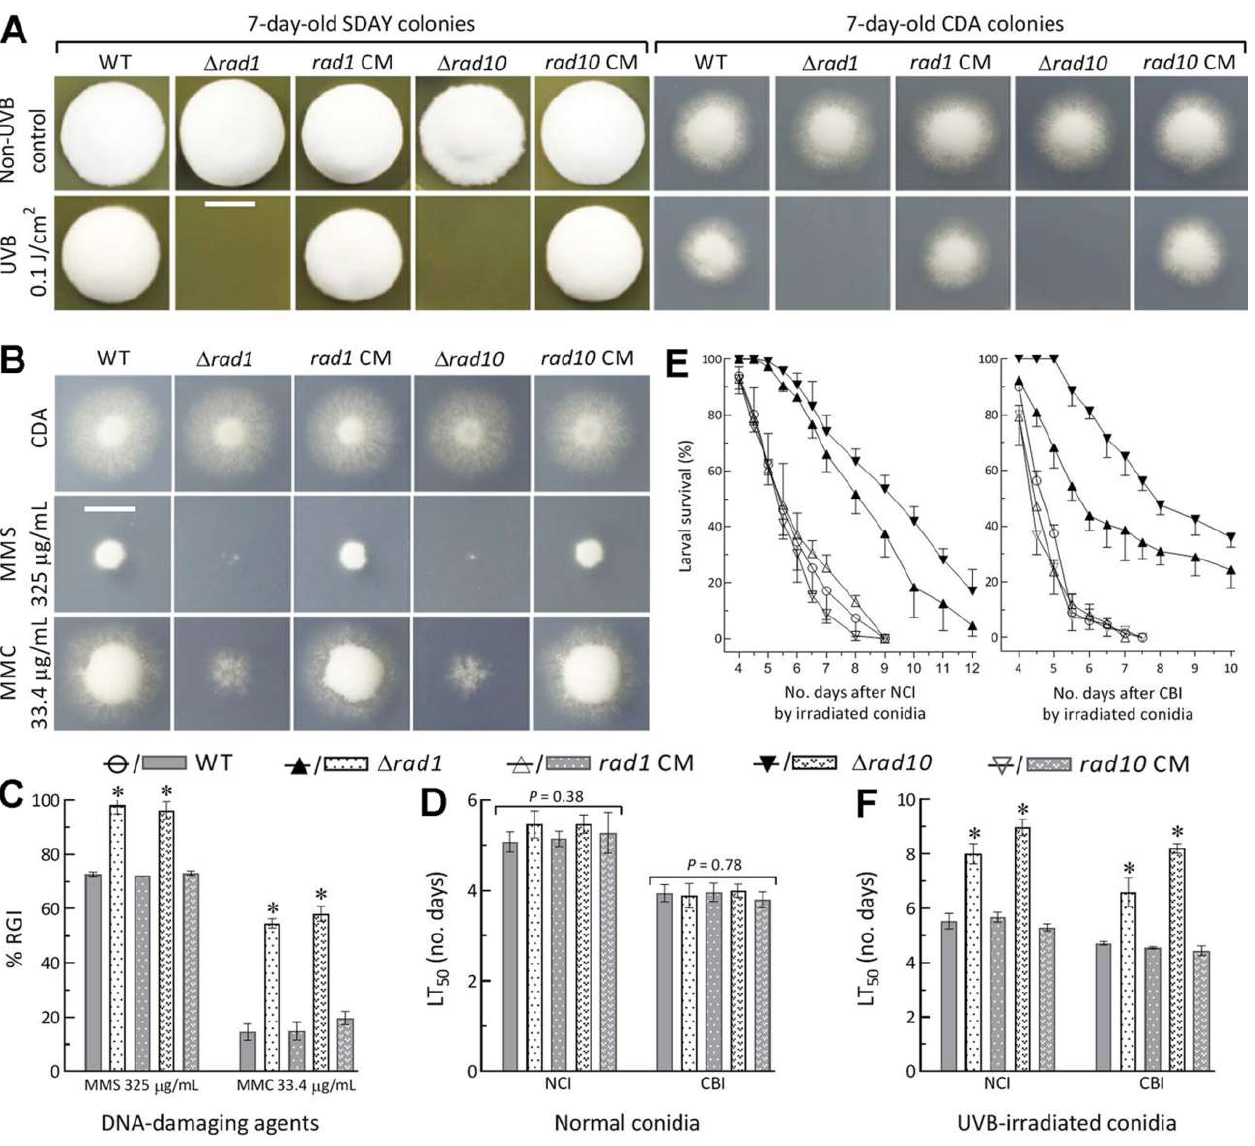
Figure 2. Essential roles of Rad1 and Rad10 in preventing B. bassiana from DNA damage. ( A ) Colony images (scale bar: 10 mm) of ∆ rad1 , ∆ rad10 , and their control (WT and CM) strains incubated at 25°C and L:D 12:12 for 7 days on SDAY and CDA plates irradiated at the UVB dose of 0.1 J/cm 2 after initiation of colony growth. ( B , C ) Colony images (scale bar: 10 mm) and relative growth inhibition (RGI) of the strains incubated at the same regime for 7 days on CDA plates containing the indicated concentrations of methyl methanesulfonate (MMS) and mitomycin C (MMC). All colonies in ( A – C ) were initiated with ~10 3 conidia. ( D ) LT 50 estimates for tested strains against G. mellonella larvae inoculated with normal conidia for normal cuticle infection (NCI) and cuticle-bypassing infection (CBI). ( E , F ) Larval survival trends and LT 50 estimates made from the trends via NCI and CBI initiated with the tested strains’conidia irradiated at the UVB dose of 0.1 J/cm 2 . * p < 0.01 ( C , F ) in Tukey’s HSD tests. Error bars in ( C – F ): standard deviations (SDs) from three independent replicates.